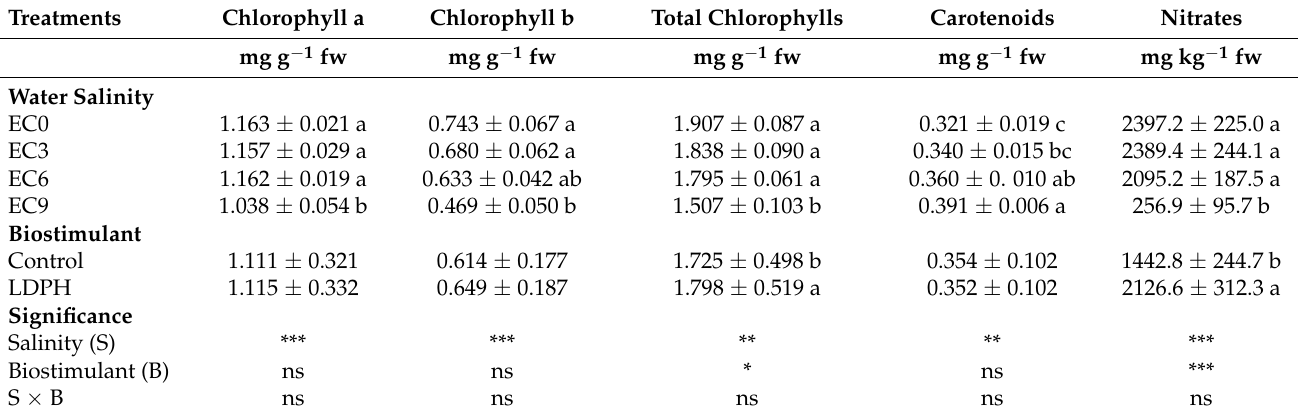
Table 4. Effects of irrigation water salinity and biostimulant application on chlorophylls a, b, and total, and carotenoids of spinach